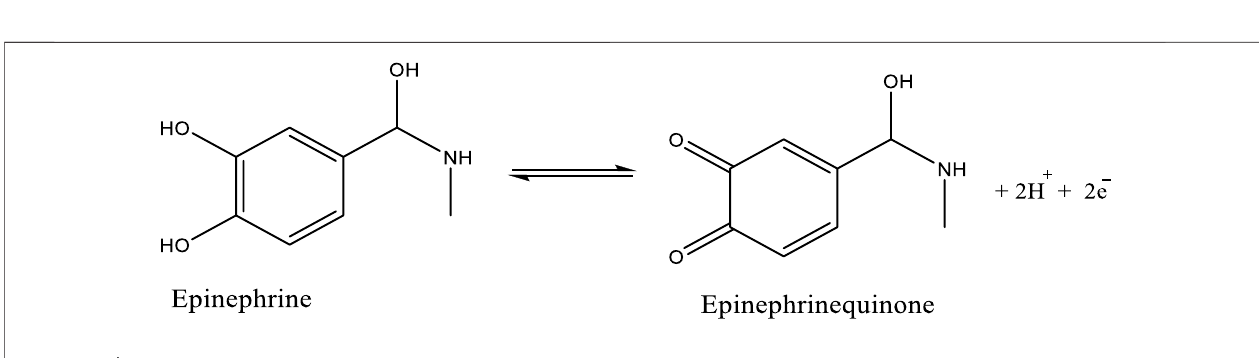
SCHEME 3 | Redox reaction of